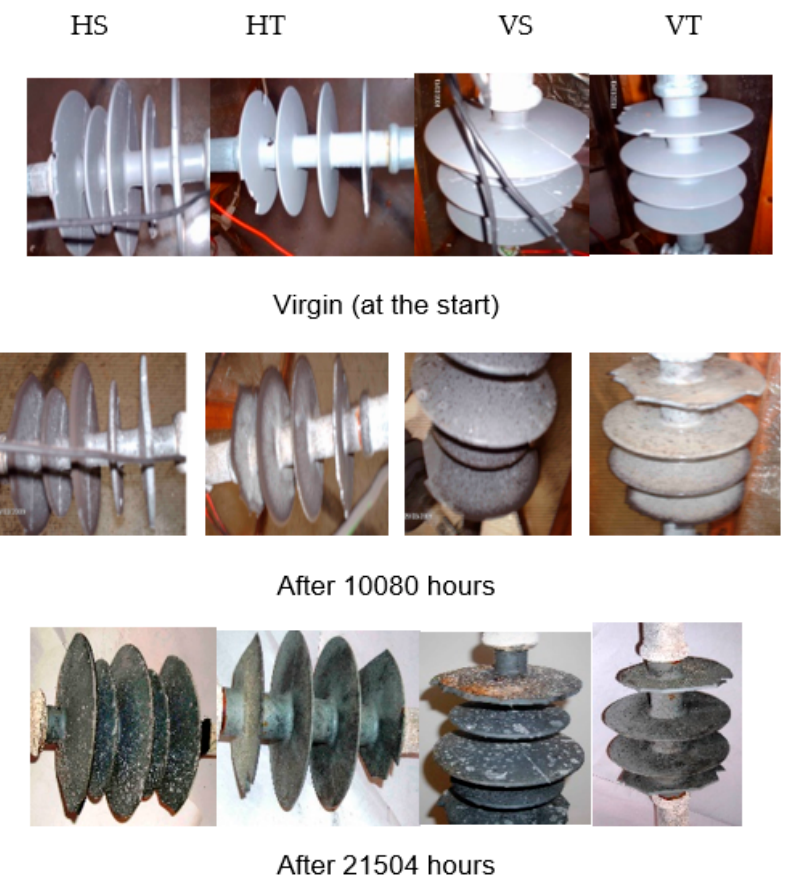
Figure 2. Results of visual observation.